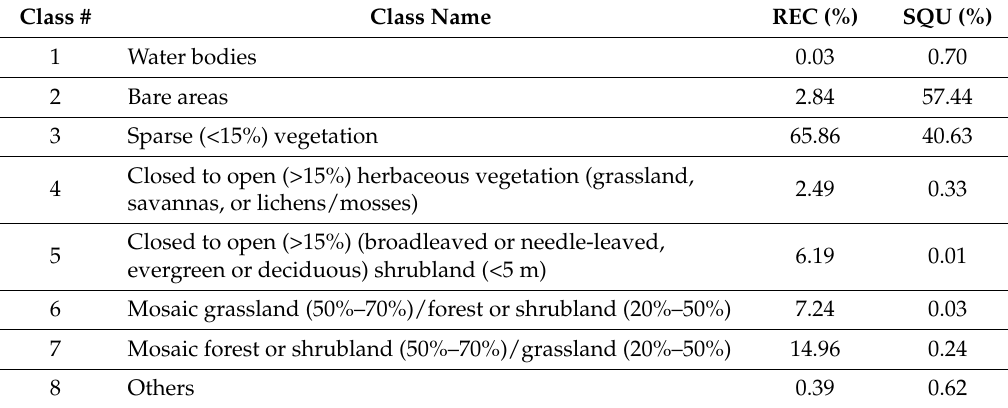
Table 1. Land cover types of Figure 1 and the percentages of sub-regions REC and SQU.